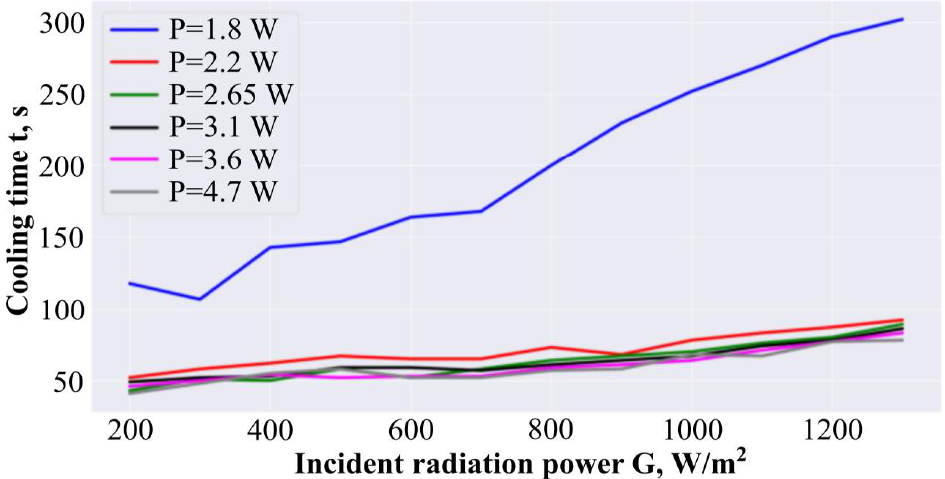
Figure 14. Cooling time of the solar cell depends on the incident radiation power.